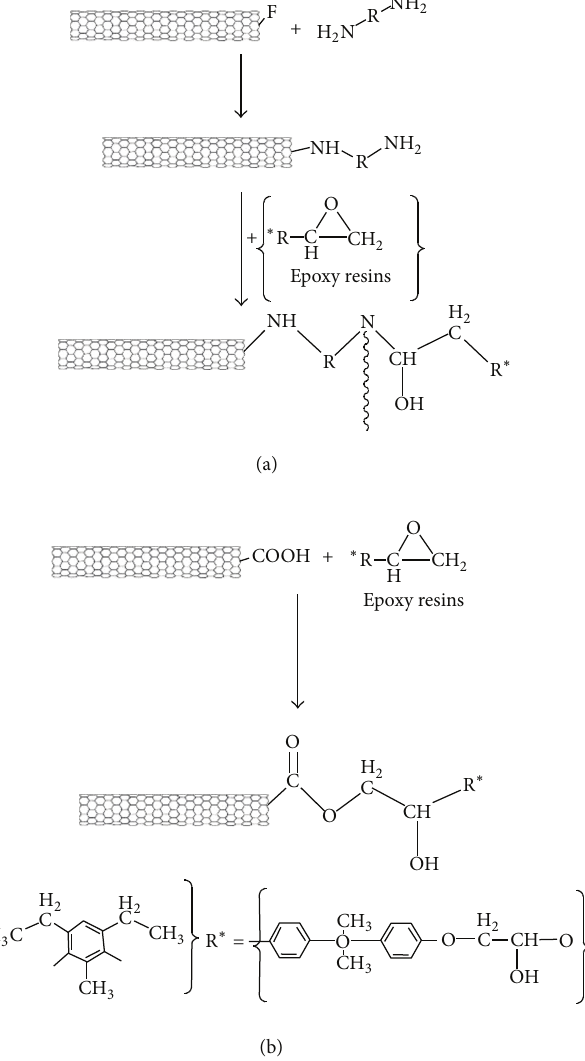
Scheme 6: Schematic representation of the reaction between functionalized MWCNTs with DGEBA resin: (a) fluorinated CNT; (b) carboxylated